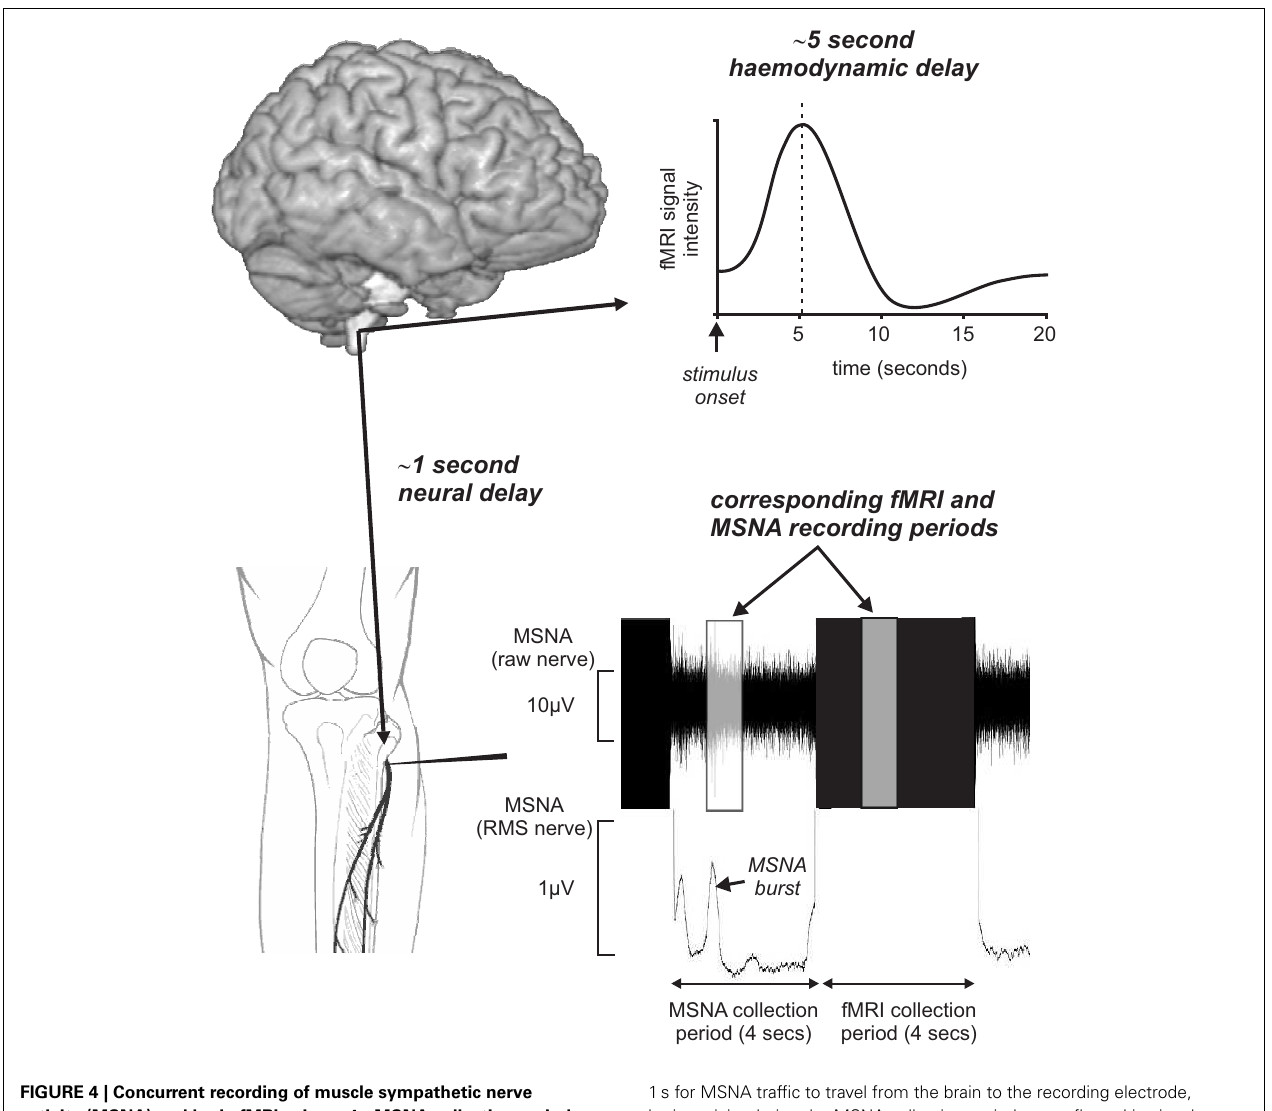
FIGURE 4 | Concurrent recording of muscle sympathetic nerve activity (MSNA) and brain fMRI using a 4s MSNA collection period followed by a 4s brain fMRI collection period . Given an fMRI hemodynamic delay of approximately 5s and the delay of approximately